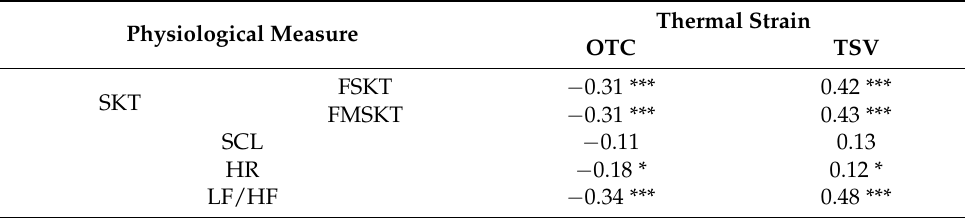
Table 4. Overall correlation between each physiological measure and thermal strain during experi- ment tested by repeat measurement correlation method. Thermal Strain Physiological Measure OTC TSV FSKT − 0.31 *** 0.42 *** SKT FMSKT − 0.31 *** 0.43 *** SCL − 0.11 0.13 HR − 0.18 * 0.12 * LF/HF − 0.34 *** 0.48